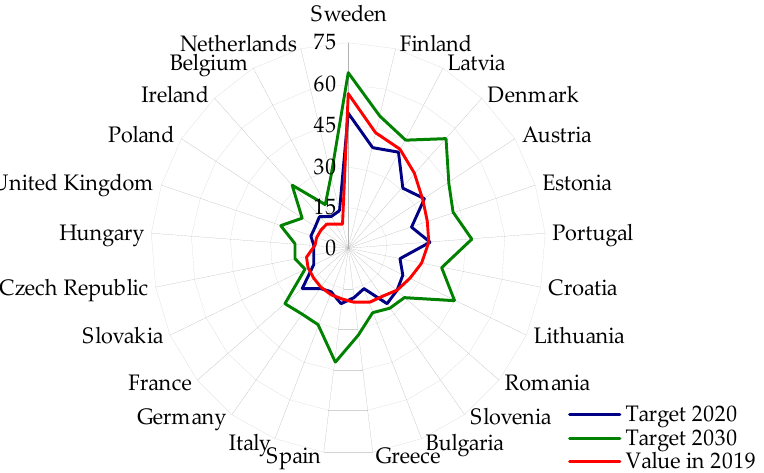
Figure 3. Share of renewable energy in gross final energy consumption in year 2019 and target 2020 and 2030 (%). Source: Own study based on [47].